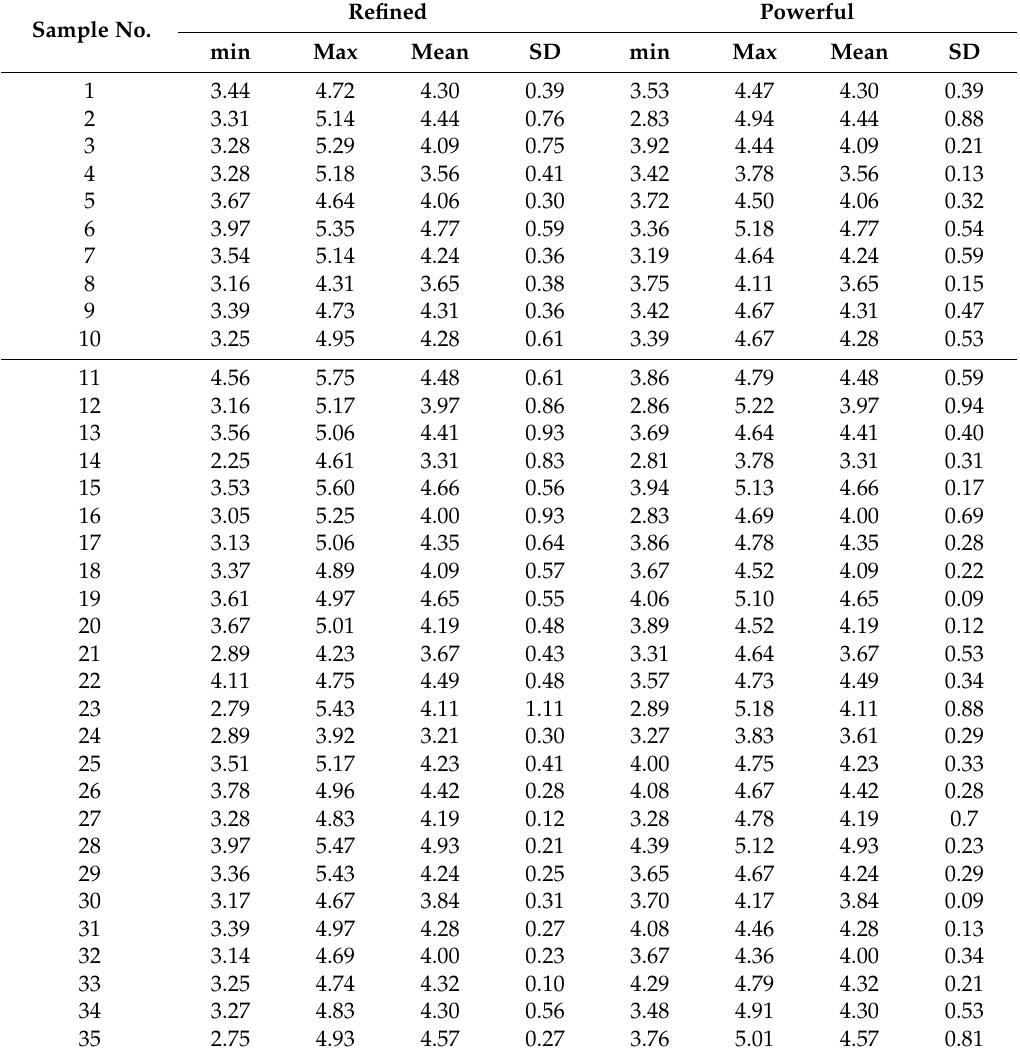
Table 4. Descriptive statistics for affective dimensions in